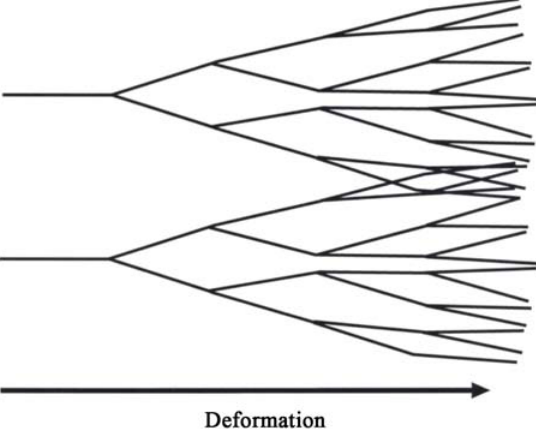
Fig. 13. The mechanism of multiplication of the shear bands as a result of interacting with the frontal